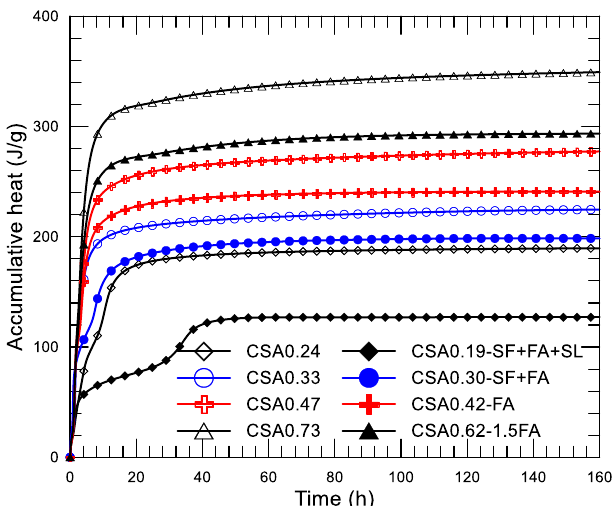
Figure 12. Accumulative heat-age diagrams of CSA pastes with different of w/c and SCMs. First, Figure 9a,b offer a double confirmation of the action of SF, i.e., advancing the first reaction peak (from 1.5 h of CSA0.24 and CSA0.33 to about 0.8 h of CSA0.19-SF+FA+SL and CSA0.30-SF+FA) and delaying the second reaction peak (from 10.5 h of CSA0.24 and 3.5 h of CSA0.33 to about 35 h of CSA0.19-SF+FA+SL and 7.5 h of CSA0.30-SF+FA). The action of nucleation and consolidation of SF in the paste is obvious. Second, the effect of w/c on the heat-releasing characteristic of the CSA paste is confirmed again.